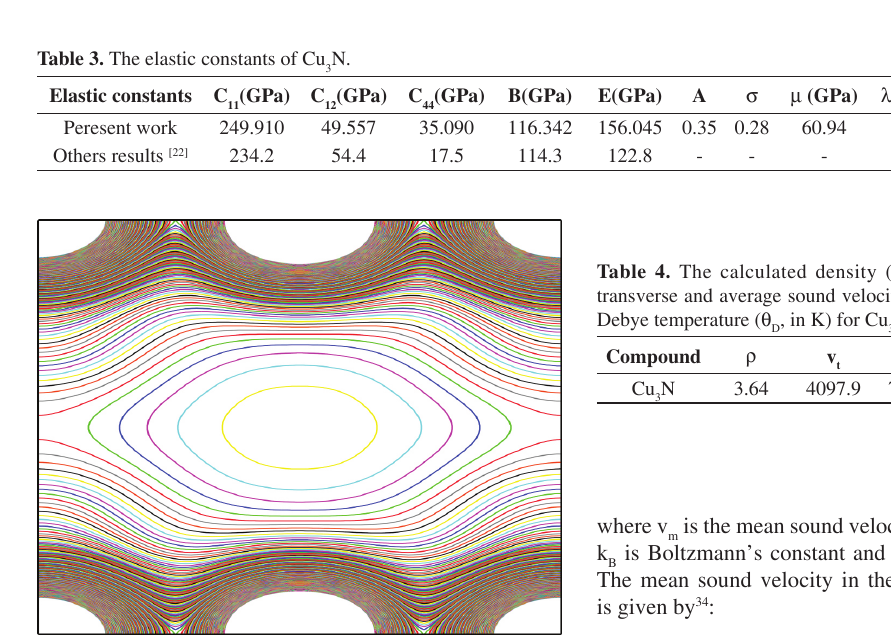
N in the (110) plane. 3